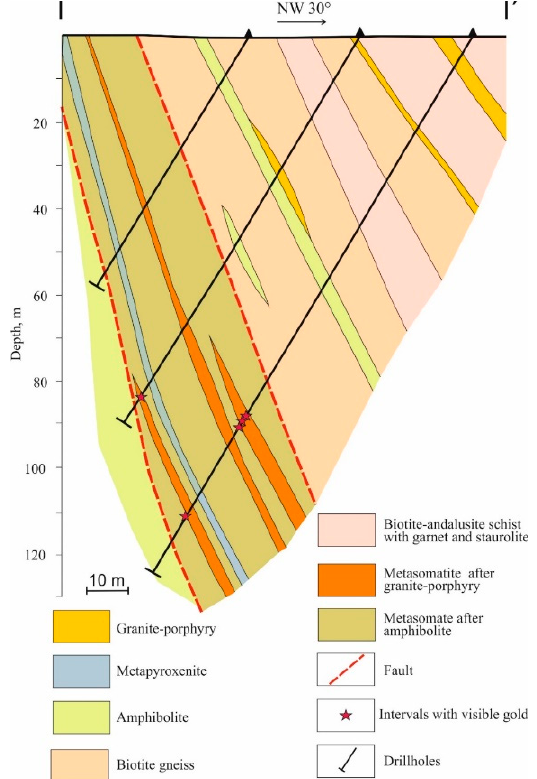
Figure 10. Schematic cross-section of the main mineralized zone of the Oleninskoe deposit along I– I’ line (Figure 9).